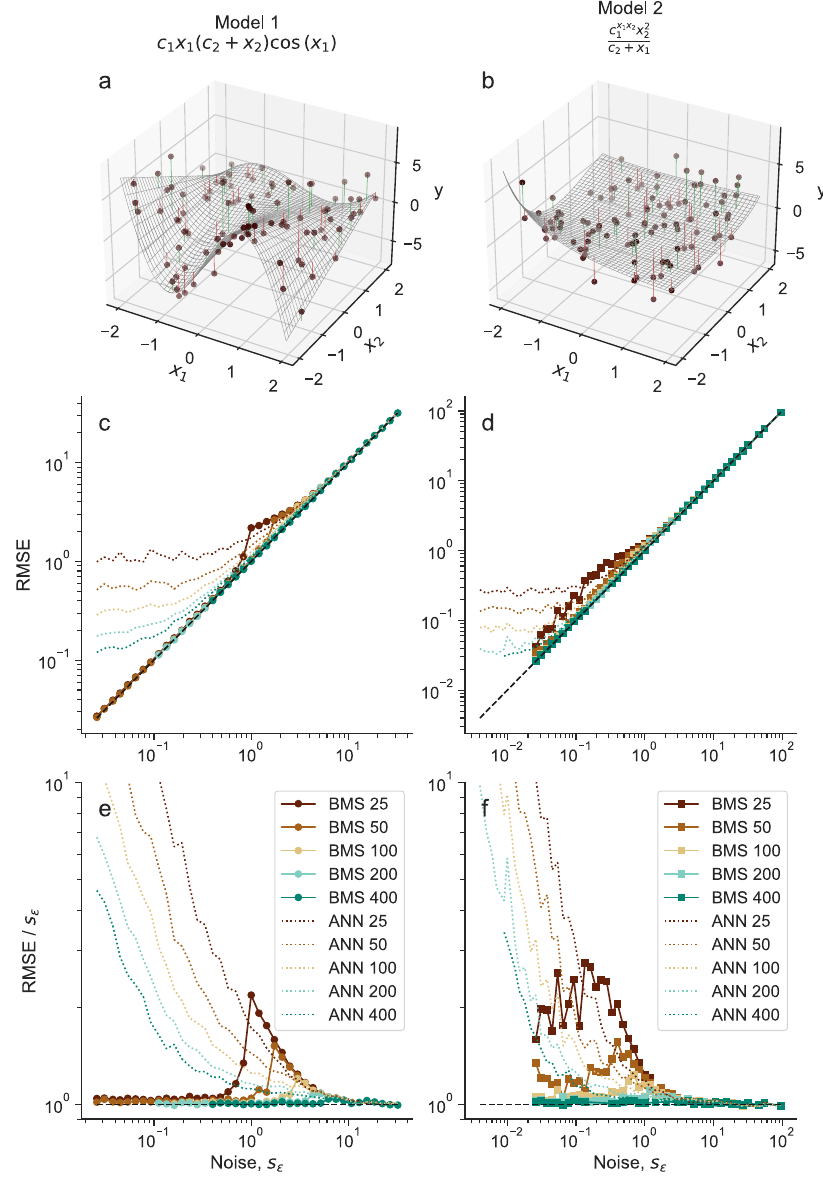
Fig. 1 | Probabilistic model selection makes quasi-optimal predictions about unobserved data. We select two models m * , whose expressions are shown at the topofeachcolumn. a , b Fromeachmodel,wegeneratesyntheticdatasets D with N points (shown, N =100) and different levels of noise s ϵ (shown, s ϵ =1). Here and throughout the article, the values of the independent variables x 1 and x 2 are gen- erated uniformly at random in [ − 2,2]. Vertical lines show the observation error ϵ i for each point in D . For a model not drawn from the prior and data generated differently, see Supplementary Fig. S1. c , d For each dataset D (with dataset sizes N ∈ {25,50,100,200,400}), we sample models from p ( m ∣ D ) using the Bayesian